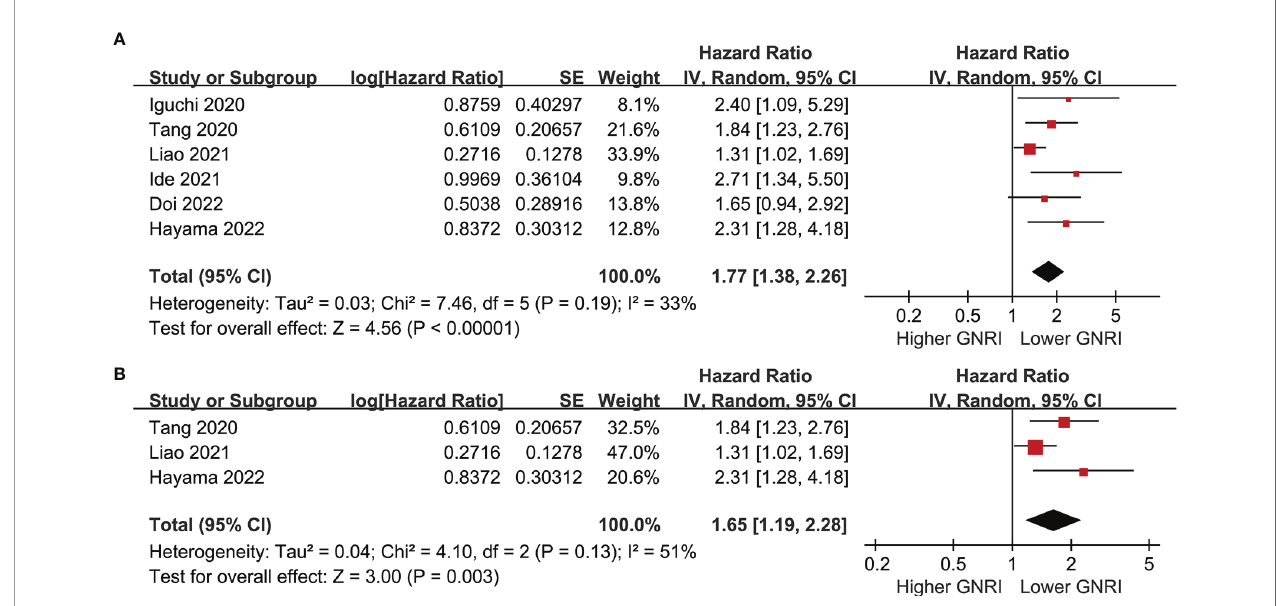
FIGURE 4 | Forest plots for the meta-analysis regarding the association between GNRI and PFS in patients with CRC; (A) overall meta-analysis; and (B) sensitivity analysis limited to the elderly